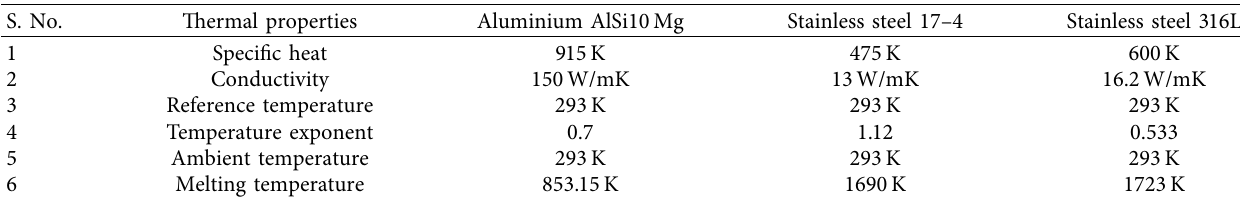
Table 2: Thermal Properties of materials for 3-blade Propeller.